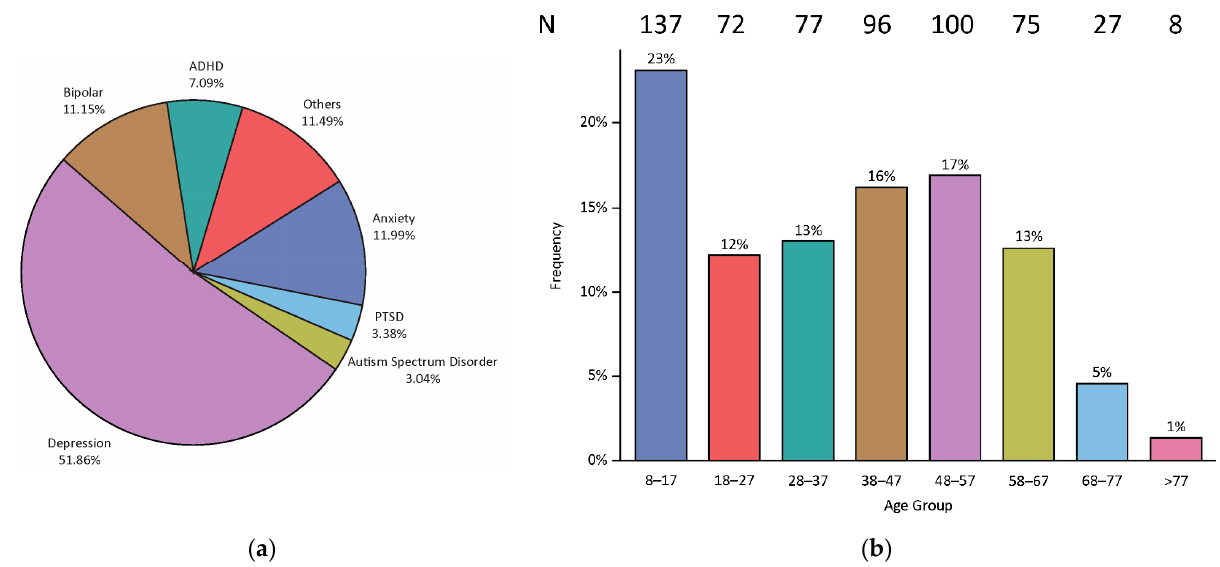
Figure 1. Patient diagnoses and ages. ( a ) A majority of individuals receiving PGx testing had a primary diagnosis of MDD or anxiety disorder followed by other and bipolar disorders. ( b ) Patients ranged in age from 8 to greater than 77 years, but a majority were between the ages of 8 and 17. ADHD: Attention Deficit Hyperactivity Disorder PTSD: Post-Traumatic Stress Disorder Table 1. PGx cohort demographics.